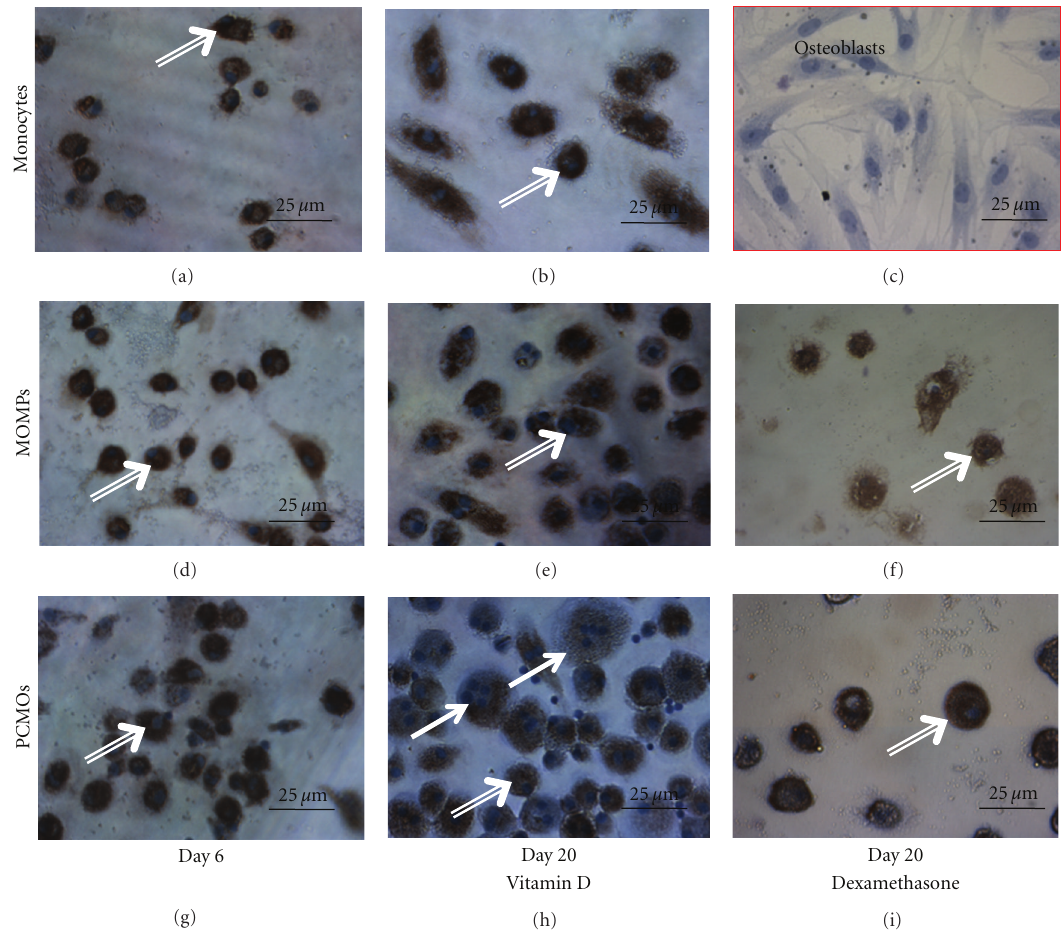
Figure 2: Di ff erentiated monocytes (Mo), MOMPs (M), and PCMOs (P) express CD68. Representative picture of immunohistochemistry against CD68 in Mo, M, and P ( N = 3, n = 3). After treatment to obtain MOMPs and PCMOs (“day 6;” first column) all cell types are positive for CD68. 20 days after the di ff erentiation—either with vitamin D (column 2) or dexamethasone (column 3)—cells also expressed CD68, while primary osteoblasts proved to be negative for CD68. Magnification 200x. Following di ff erentiation with vitamin D, high numbers of giant cells (marked with → ) appear. Macrophage-like cells are marked with ⇒